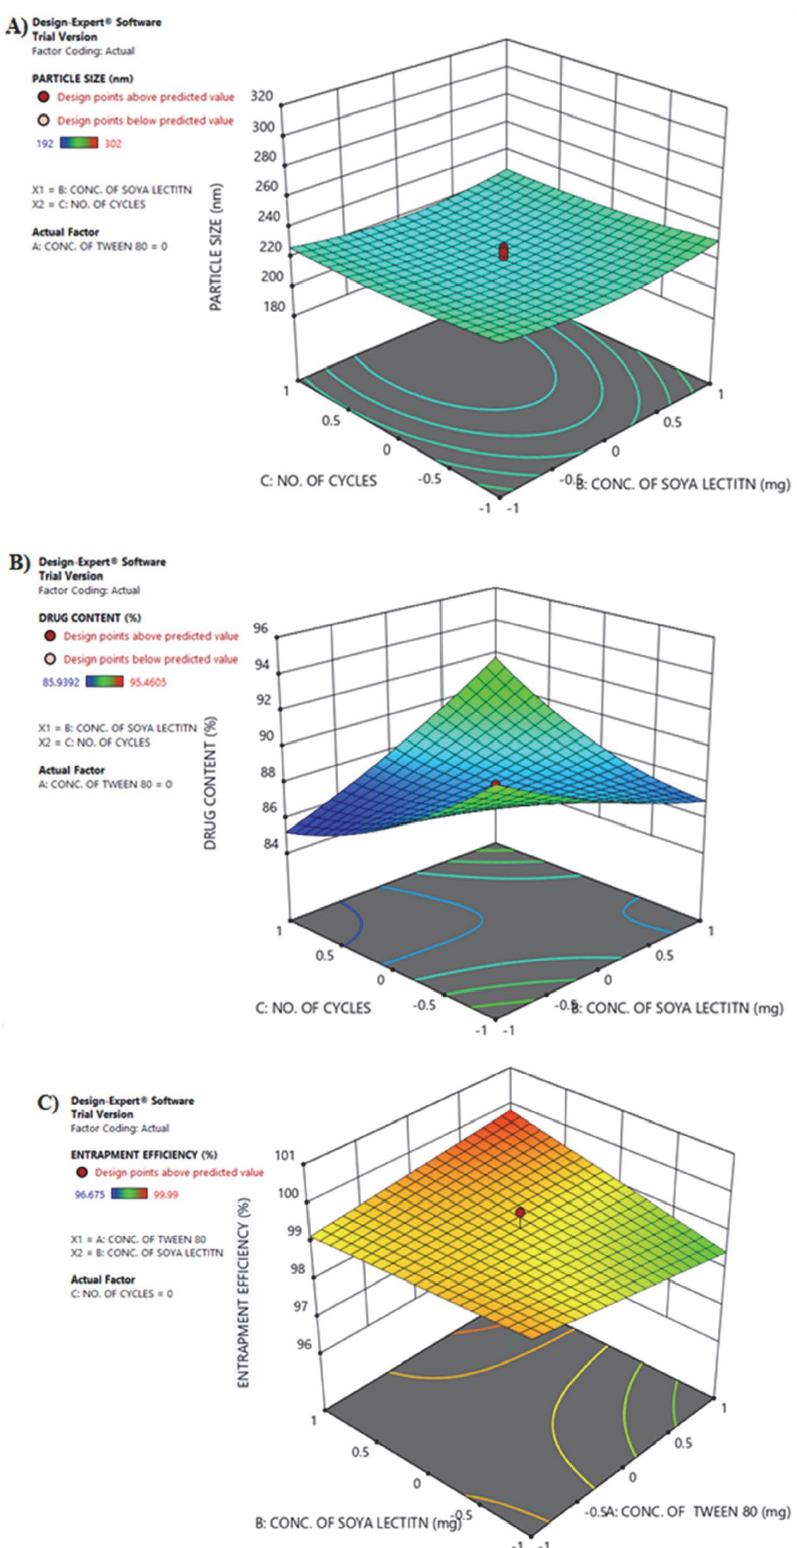
Figure 4. 3D surface response plot showing: a) The effect of factor C (number of cycles) and factor B (concentration of soya lecithin) on response Y1 (particle size). B) The effect of factor C (number of cycles) and factor B (concentration of soya lecithin) on response Y2 (drug content). C) The effect of factor B (concentration of soya lecithin) and factor A (concentration of tween 80) on response Y2 (drug